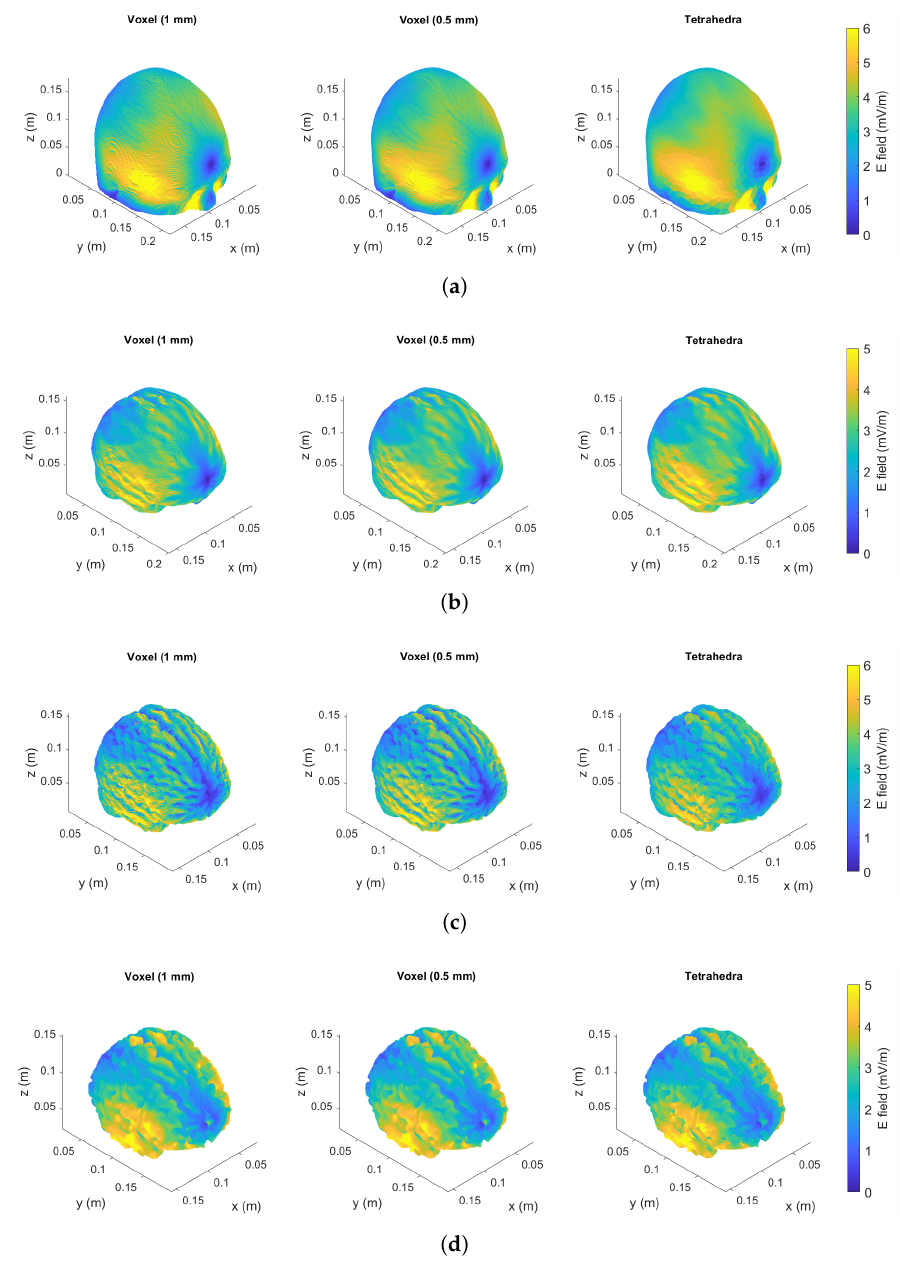
Figure 6. Localized exposure (coil in front of the head model). The induced electric field in Colin27 Average Brain is shown for tetrahedral mesh and voxel-based meshes with resolution of 1 mm e 0.5 mm in each tissue: skull ( a ), CSF ( b ), grey matter ( c ) and white matter ( d